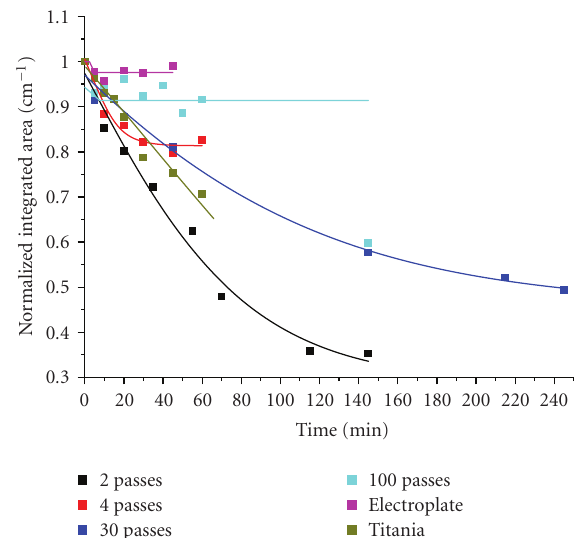
Figure 3: UV photoactivity for Ag films of di ff ering thickness (2, 4, 30, and 100 passes). Also included are the results for the electroplate silver ( ) and an 80 nm thick film of titania (